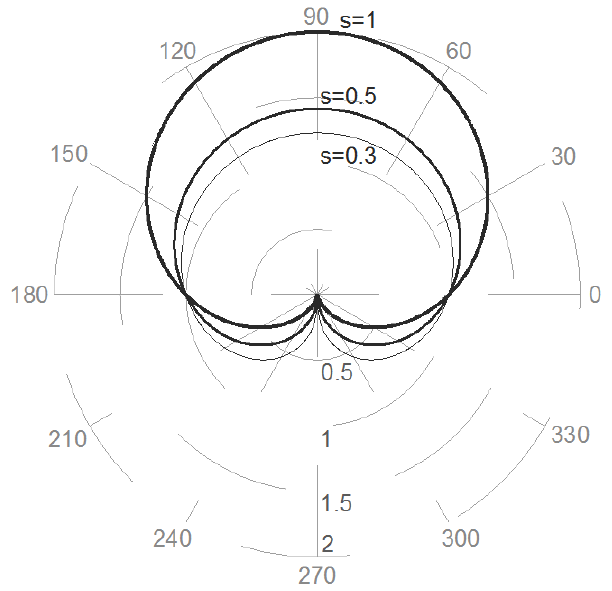
Fig. 1. Examples of the CT image slices.